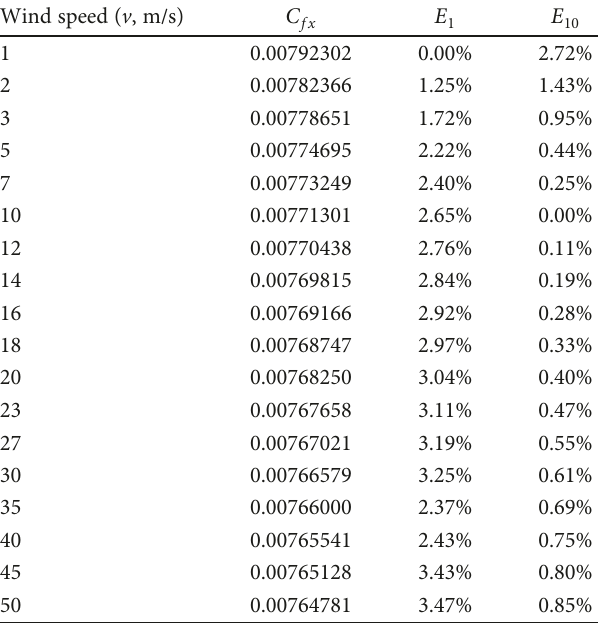
Figure 4: The coordinate system of the model. Table 1: Deviation data.